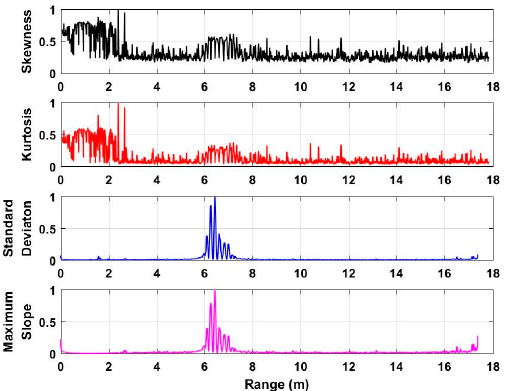
Figure 13. The distance estimates based on the acquired data from one human being at a distance of 6 m indoors with 60° azimuth.